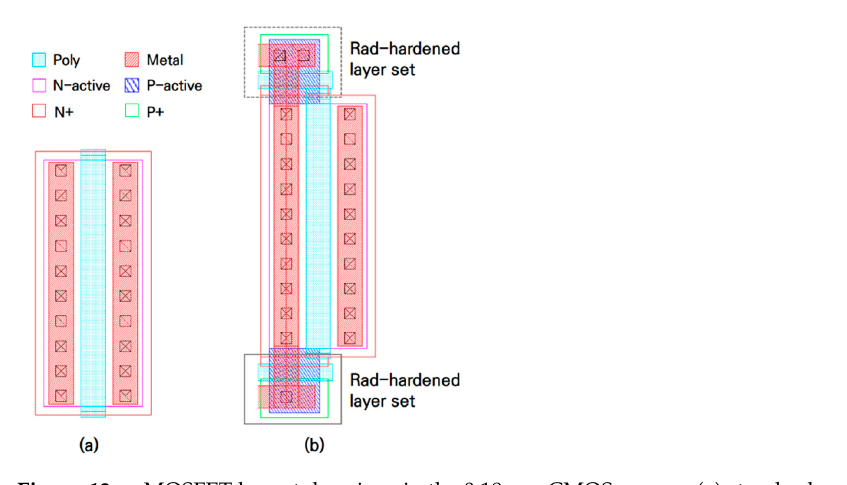
Figure 14. Leakage current measurements with respect to increasing cumulative doses ( a ) stand- ard and ( b ) RH V-gate n-MOSFET. 4. Conclusions In the present study, a radiation-tolerant MOSFET structure was optimized in an at- tempt to ensure electronic devices will maintain their original performance when exposed to radiation environments. M&S techniques were employed to conduct a radiation effect assessment and allowed us to attempt to modify the layout structure using various pat- terns as desired. This approach helped us to determine reliable estimates of the radiation- tolerance characteristics of the designed structures before starting the actual manufactur- ing of the semiconductor chips, thereby minimizing research and development costs and time. We compared and analyzed the damage and tolerance characteristics of n-MOSFETs through the radiation injection M&S and proposed a radiation-hardened variable-gate n- MOSFET. The proposed RH VG n-MOSFET was designed and fabricated in the 0.18-um CMOS process, and radiation exposure tests were performed together with the standard n-MOSFET. As a result of the radiation measurement, the radiation damage occurred in the standard n-MOSFET, but the proposed RH VG structure was confirmed to be radia- tion-tolerant up to a total cumulative dose of 2 Mrad.